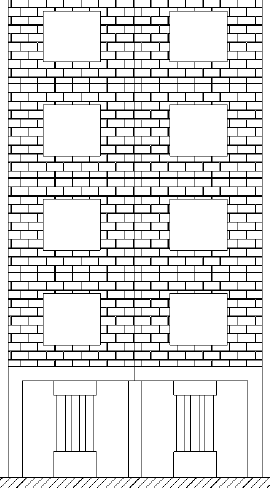
Figure 14. Masonry structure with RC frame on the first story with CFST damper.